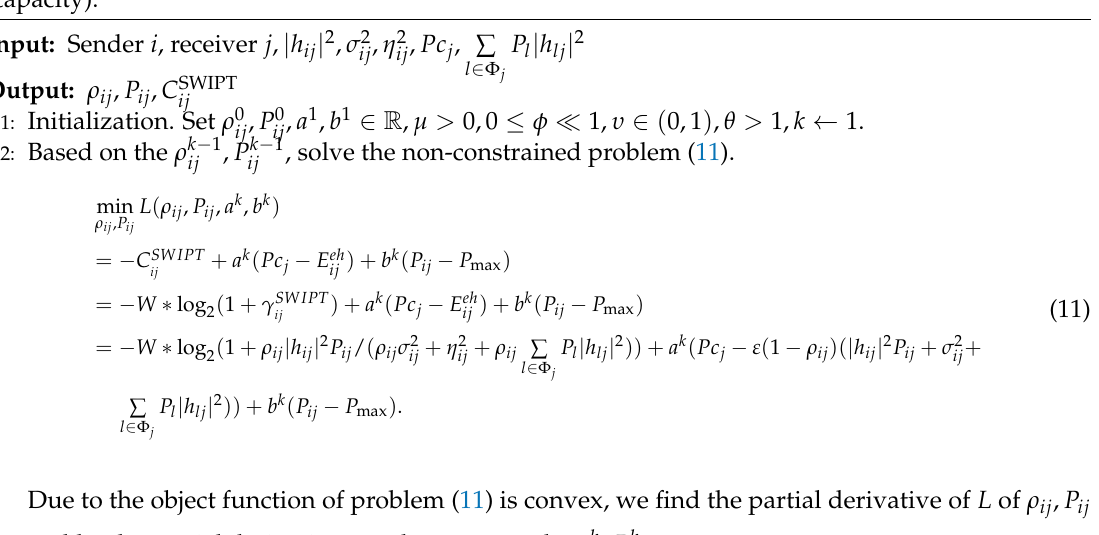
Algorithm 1 Interference-based maximum capacity information and energy allocation algorithm